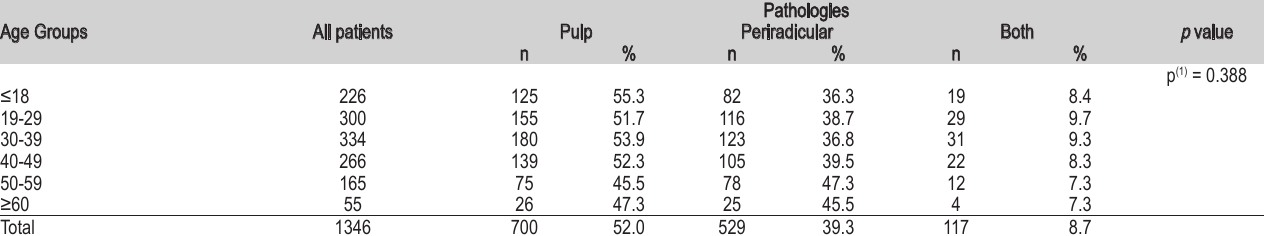
Table 2 - Prevalence of treated patients due to pulp and periradicular pathologies according to age groups.